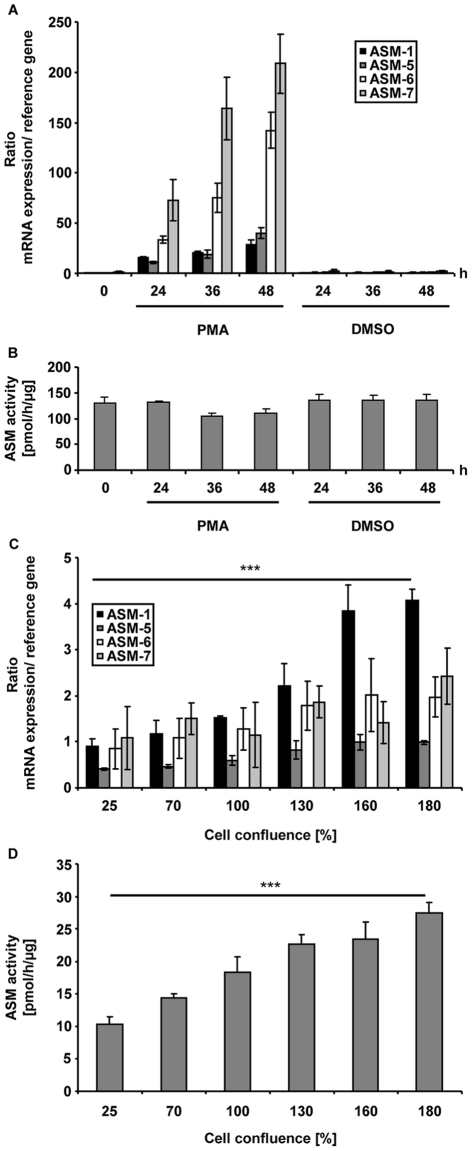
Physiological cell models confirm the dominant-negative effect of new ASM splice variants.
A. PMA induces mRNA expression of ASM isoforms in THP-1 cells. Upon PMA treatment, ASM-1 mRNA expression was time-dependently induced. Expression levels of ASM-5 to -7 rose disproportionately strong. THP-1 cells were treated with 160 nM PMA. After 24, 36 and 48 h, quantitative RT-PCR analyses were conducted. All ASM RT-qPCR values were measured in duplicates, normalised against values from the non-regulated reference gene HPRT and included primer efficiency calculations. DMSO served as a negative control. The displayed data represent mean values of triplicates, error bars denote SD. The results were replicated three times. B. ASM activity levels remain constant upon PMA treatment of THP-1 cells. Upon 24, 36 and 48 h of PMA treatment (160 nM), cell lysates were subjected to an in vitro enzyme activity assay. DMSO served as a negative control. The displayed data represent mean values of triplicates, error bars denote SD. Results were replicated three times. C. High density of H4 cells induces mRNA expression of full-length ASM-1. Depending on increasing cell density, ASM-1 mRNA expression was significantly induced (p<0.001), in contrast to the expression of splice variants ASM-5, -6 and –7. H4 cells were grown to varying levels of confluence. After 72 h, quantitative RT-PCR analyses were conducted. All ASM RT-qPCR values were measured in duplicates and normalised against values from the non-regulated reference gene HPRT. The displayed data represent the mean values of three independent experiments, error bars denote SD. Statistical significance was calculated using one-way ANOVA including a post-hoc test for linear trend (*** p<0.001). D. High density of H4 cells increases ASM activity. The increase in cellular density significantly increased cellular ASM activity (p<0.001). H4 cells were grown to varying levels of confluence. Upon 72 h cell lysates were subjected to an in vitro enzyme activity assay. The displayed data represent the mean values of three independent experiments, error bars denote SD. Statistical significance was calculated using one-way ANOVA including a post-hoc test for linear trend (*** p<0.001).